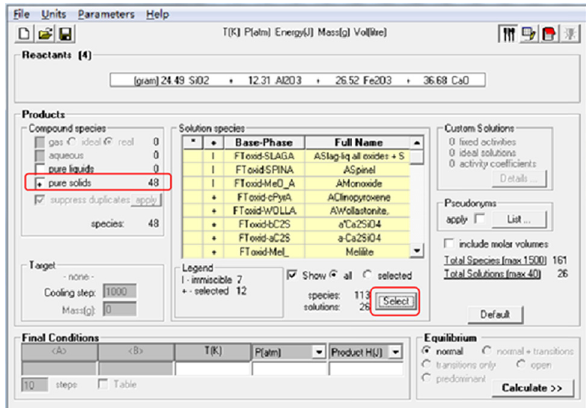
Figure A5: Calculation result of melting